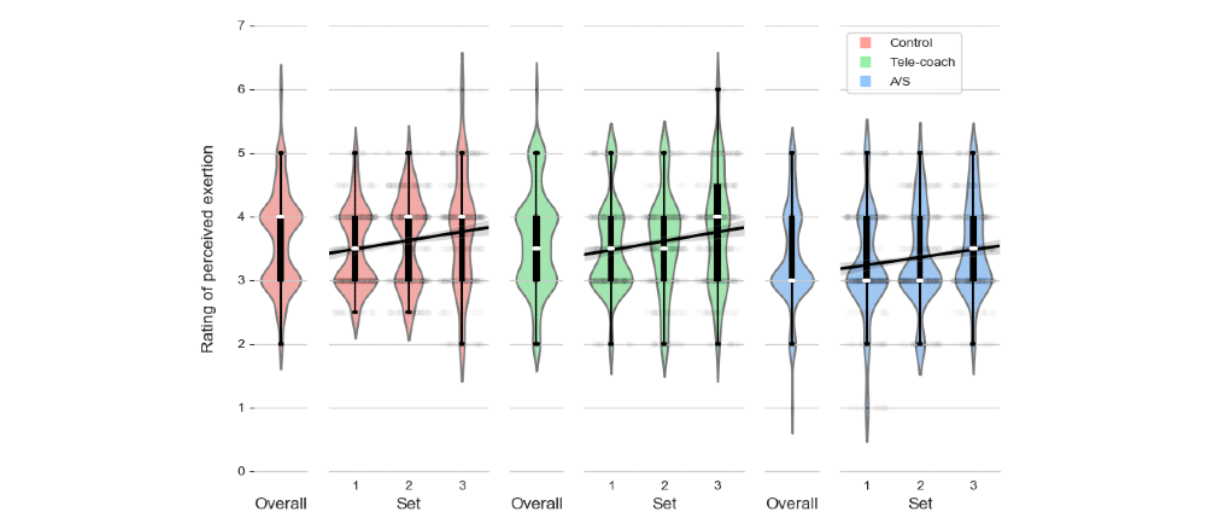
Figure 9. RPE per set, colored for each of the 3 conditions. A/S: ambient light and sonification; RPE: rating of perceived